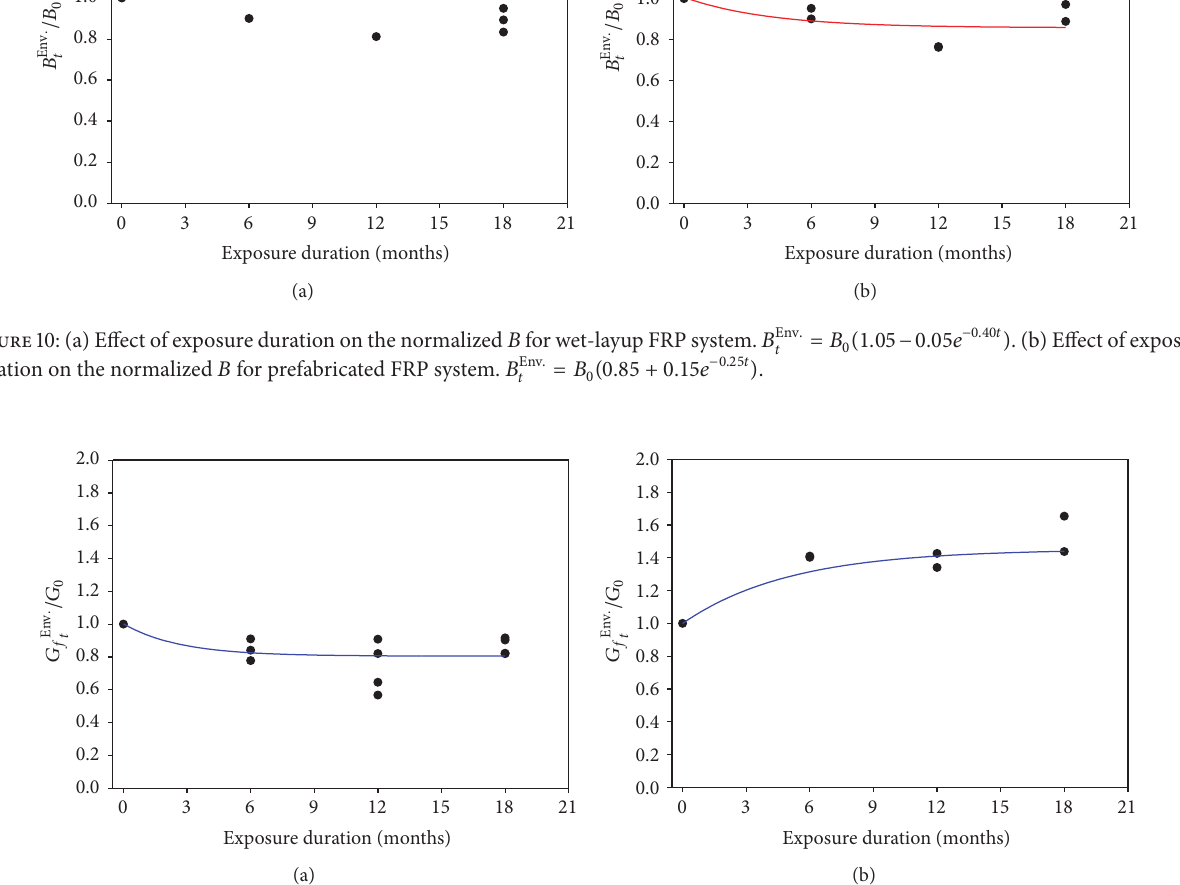
Figure 11: (a) Effect of exposure duration on the normalized 𝐺 𝑓 for wet-layup FRP system. 𝐺 𝑓 Env . duration on the normalized 𝐺 𝑓 for prefabricated FRP system. 𝐺 𝑓 Env .